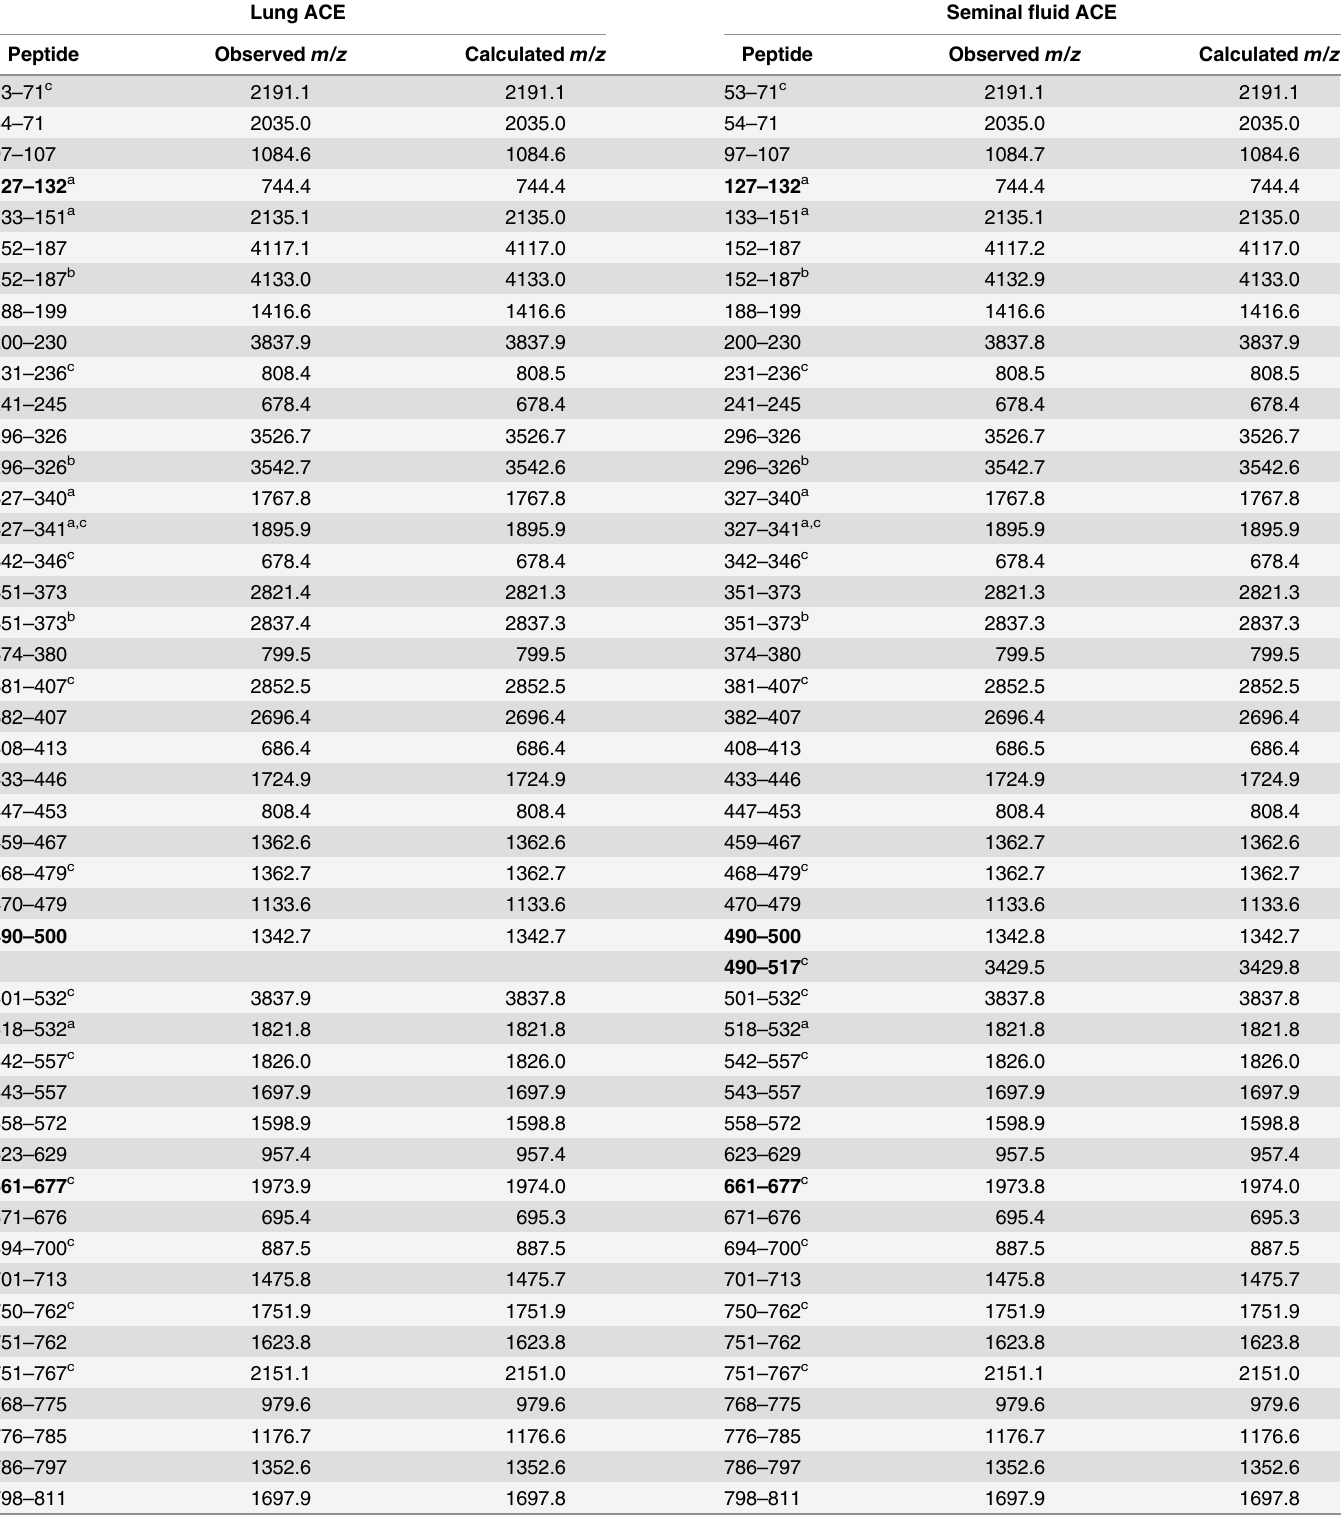
Table 1. Observed [M+H] + ions of unglycosylated peptides in the mass spectra of human ACE tryptic